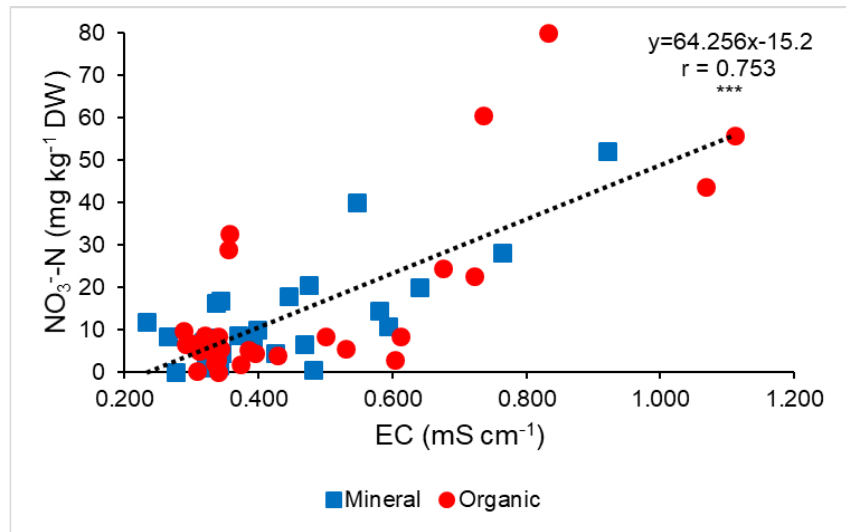
Figure 6. Correlation between electric conductivity (EC) measured by probes and soil nitrate (NO 3 − - N) concentration in organic and mineral plots (data from April to August). *** = effect of treatment significant at p ≤ 0.001